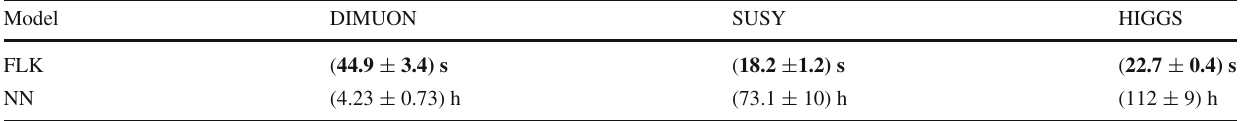
Table 1 Average training times per single run with standard deviations (low level features and reference toys). Note that time measured in hours (for NN) and seconds (for Falkon)